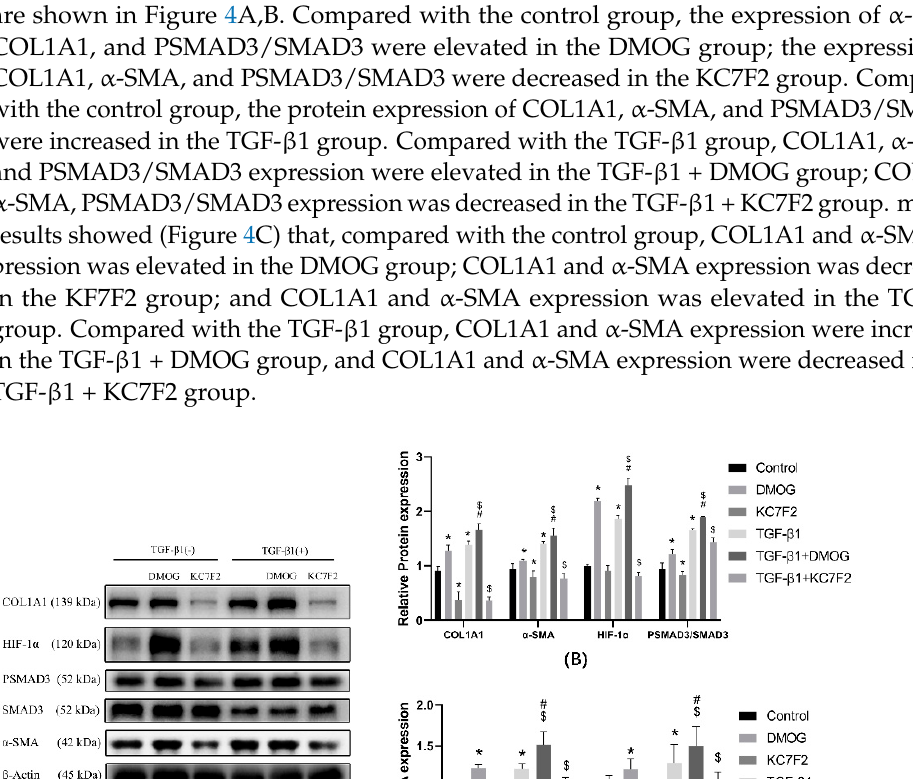
cells, and mRNA was extracted from groups. mRNA expression was determined by qPCR and normalized to β -actin. * p < 0.05 vs. control group; # p < 0.05 vs. DMOG group; $ p < 0.05 vs. and pairwise comparisons were compared by LSD-t test. A value of p < 0.05 was considered to be statistically